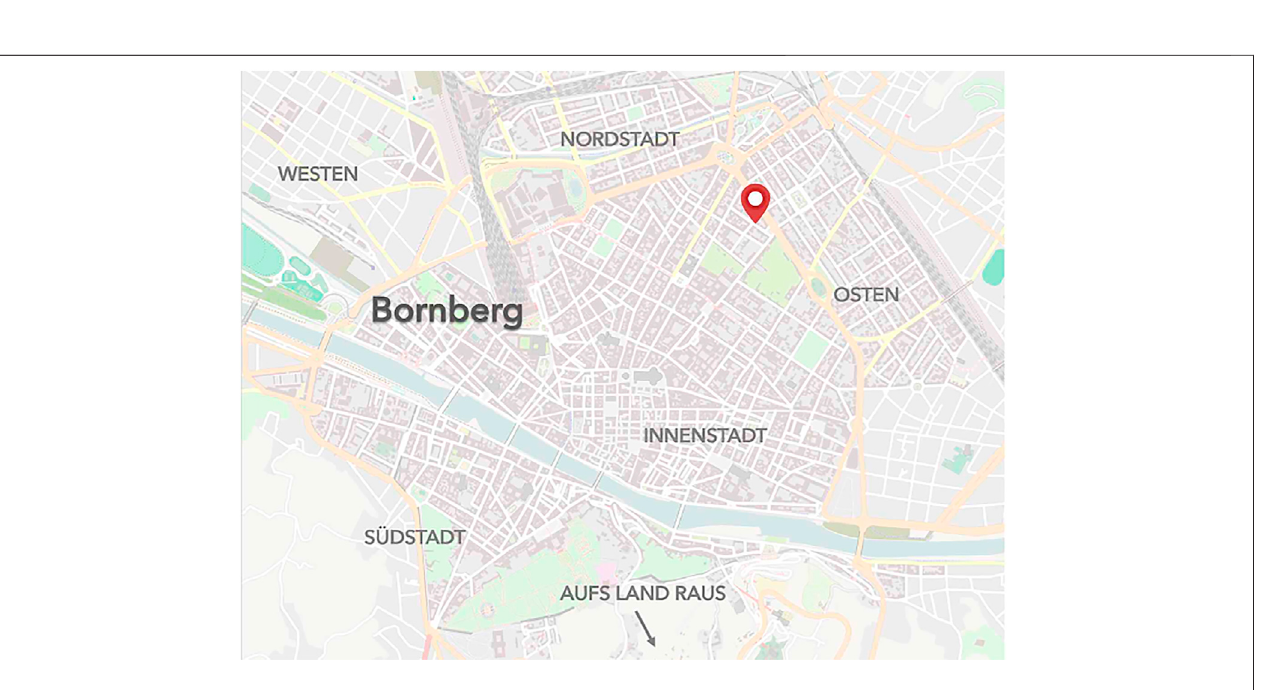
Frontiers in Computer Science |